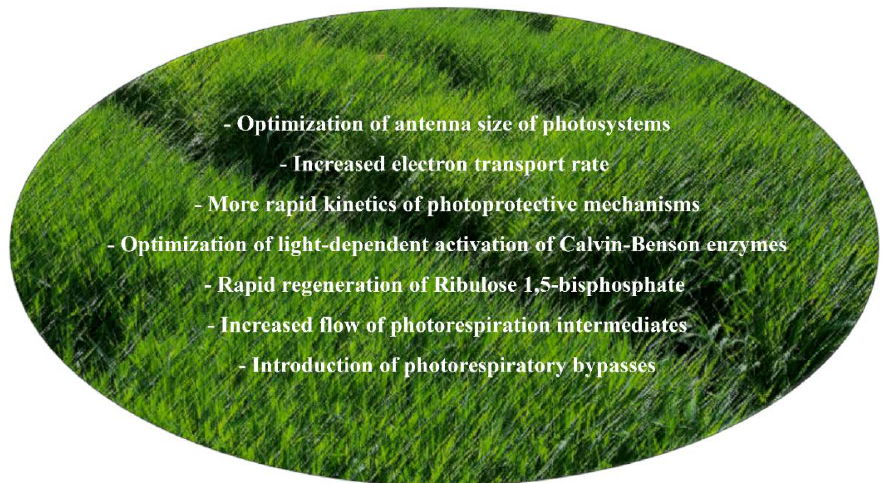
Figure 2. Biotechnological strategies that have been shown to enhance photosynthetic efficiency in model species. All of them can be applied to barley using the available genetic tools, and can potentially be improved by exploiting the genetic diversity of barley.